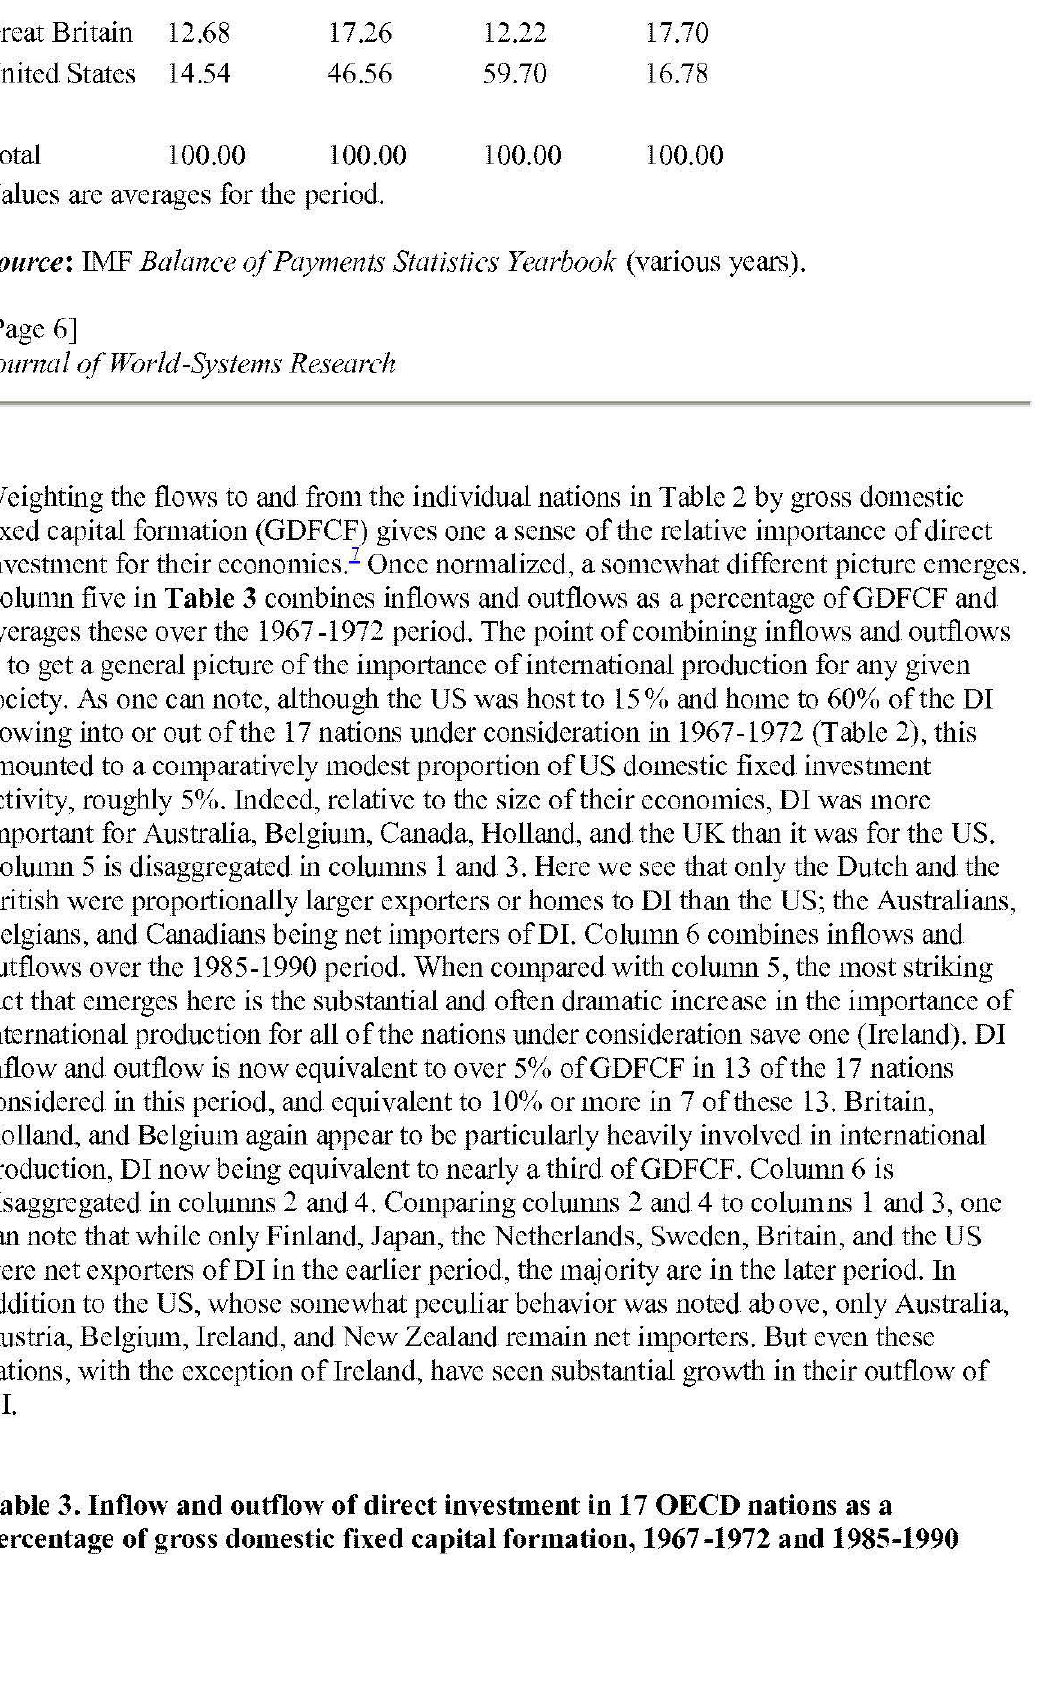
Table 3. Inflow and outflow of direct investment in 17 OECD nations as a percentage of gross domestic fixed capital formati on, 1967-1972 and